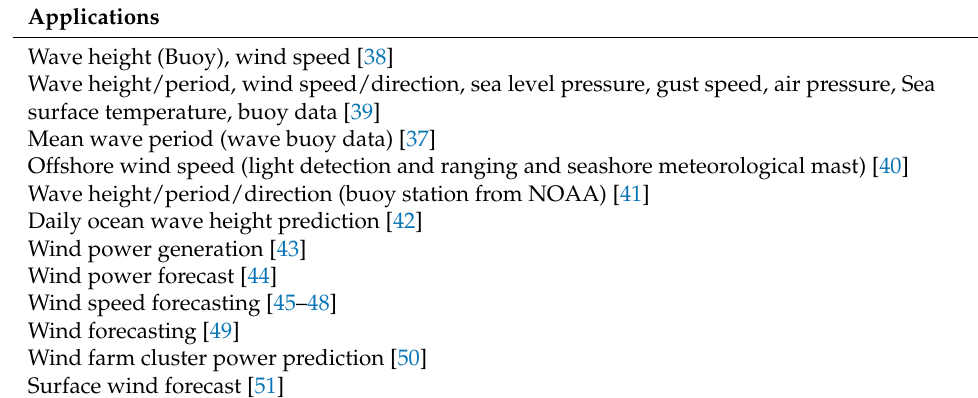
Table 1. Summary of deep learning models in wind and wave energy